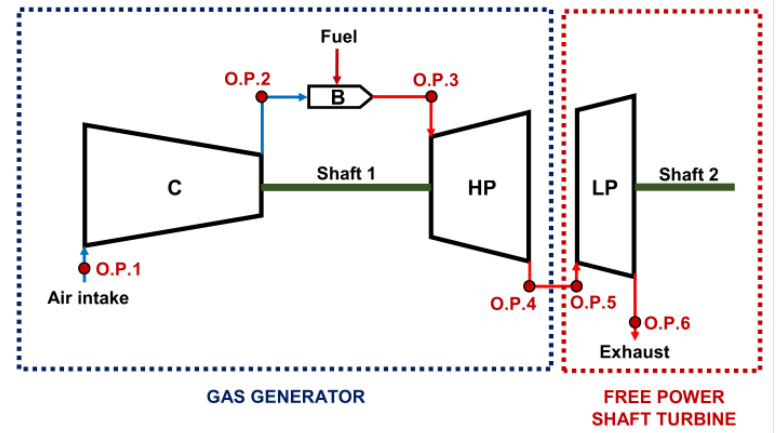
Figure 2. The scheme of GT component used in CODLAG propulsion system (C-turbo compressor; B-combustion chamber; HP-high pressure turbine; LP-low pressure turbine, O.P.-Operating